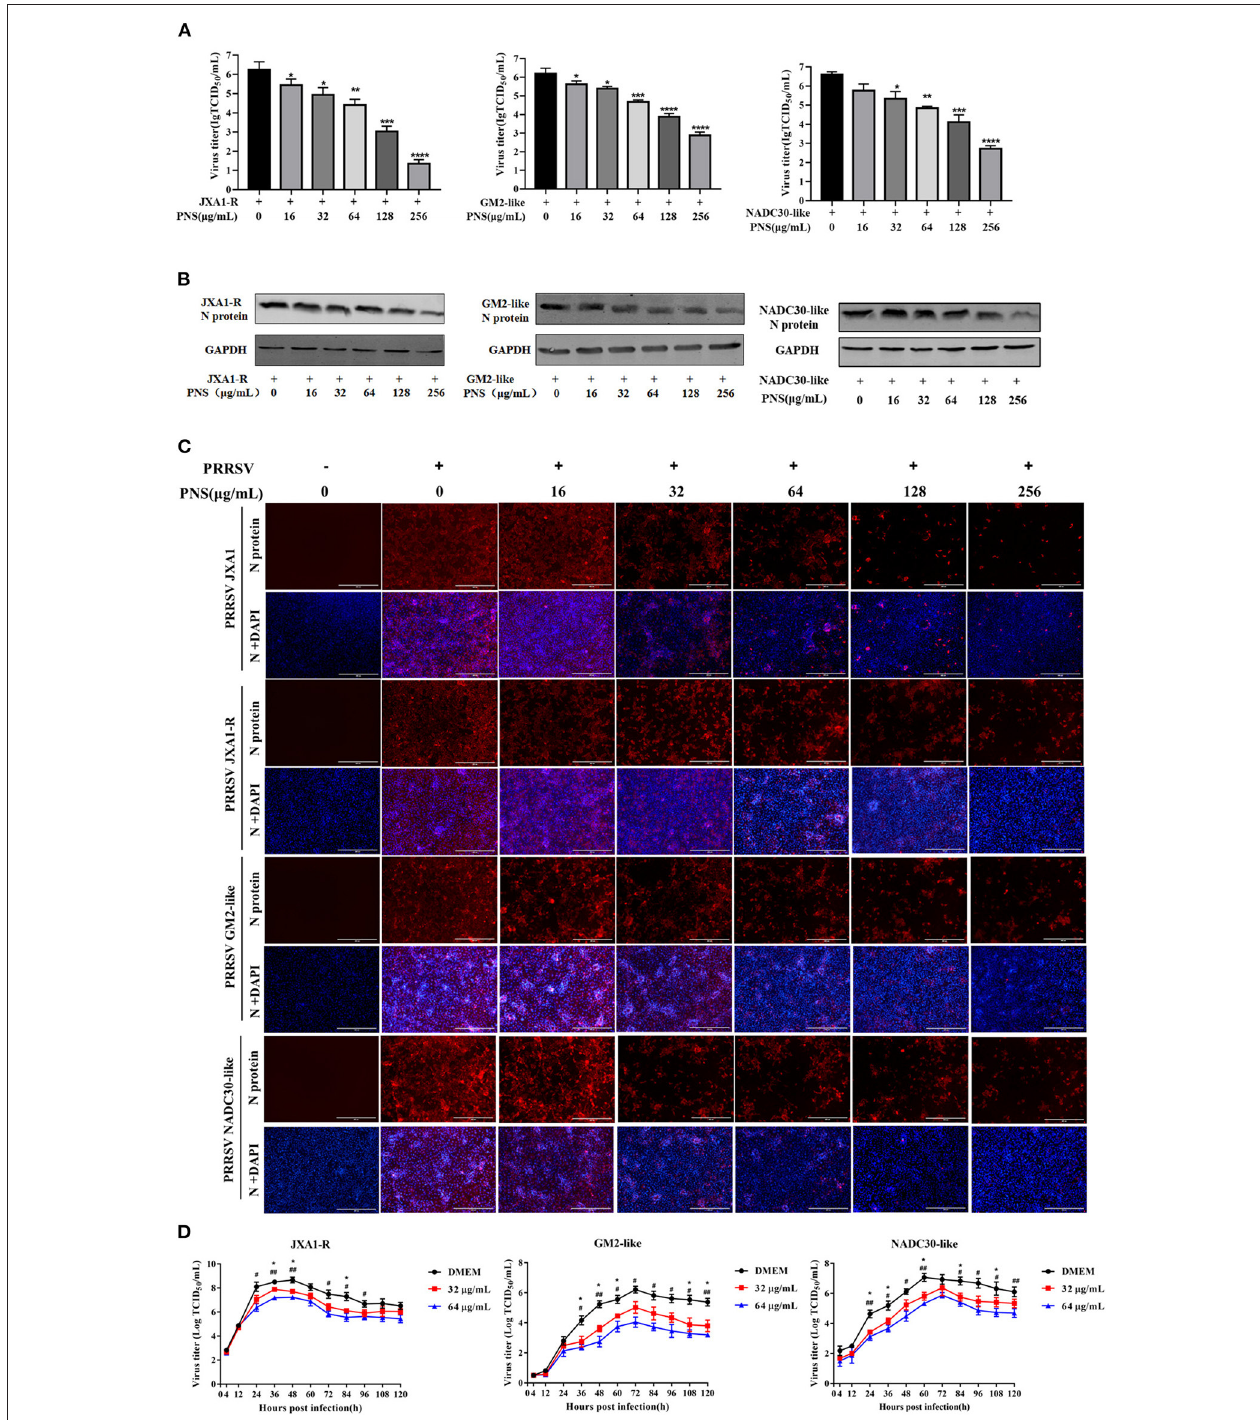
FIGURE 3 | The anti-viral activity of PNS against different lineages of type 2 PRRSV. (A–C) Anti-viral activity of PNS against PRRSV strains (JXA1-R, GM2-like, and NADC30-like) was assessed in Marc-145 cells. Marc-145 cells were treated with PNS at 0, 16, 32, 64, 128, and 256 µ g/mL for 48h after PRRSV infection (MOI of 0.05 TCID 50 per cell) for 1h. The samples were collected for the TCID 50 assay (A) , western blotting (B) , and IFA (C) . Western blotting was performed using PRRSV N-protein antibody, and GAPDH served as loading control. Marc-145 cells were immunostained for the PRRSV N-protein antibody with an Alexa Fluor 594-conjugated goat anti-mouse antibody (Red). (D) Marc-145 cells were infected with PRRSV (JXA1-R, GM2-like, NADC30-like) (MOI of 0.05 TCID 50 per cell) for 1h at 37 ◦ C and cultured in DMEM supplemented with indicaited concentrations of PNS. Supernatants were collected 4, 12, 24, 36, 48, 60, 72, 84, 96, 108, 120 hpi for virus titer determination. Statistical significance is denoted by * p < 0.05, ** p < 001, *** p < 0.001, **** p < 0.0001. # p < 0.05, ## p < 0.01.